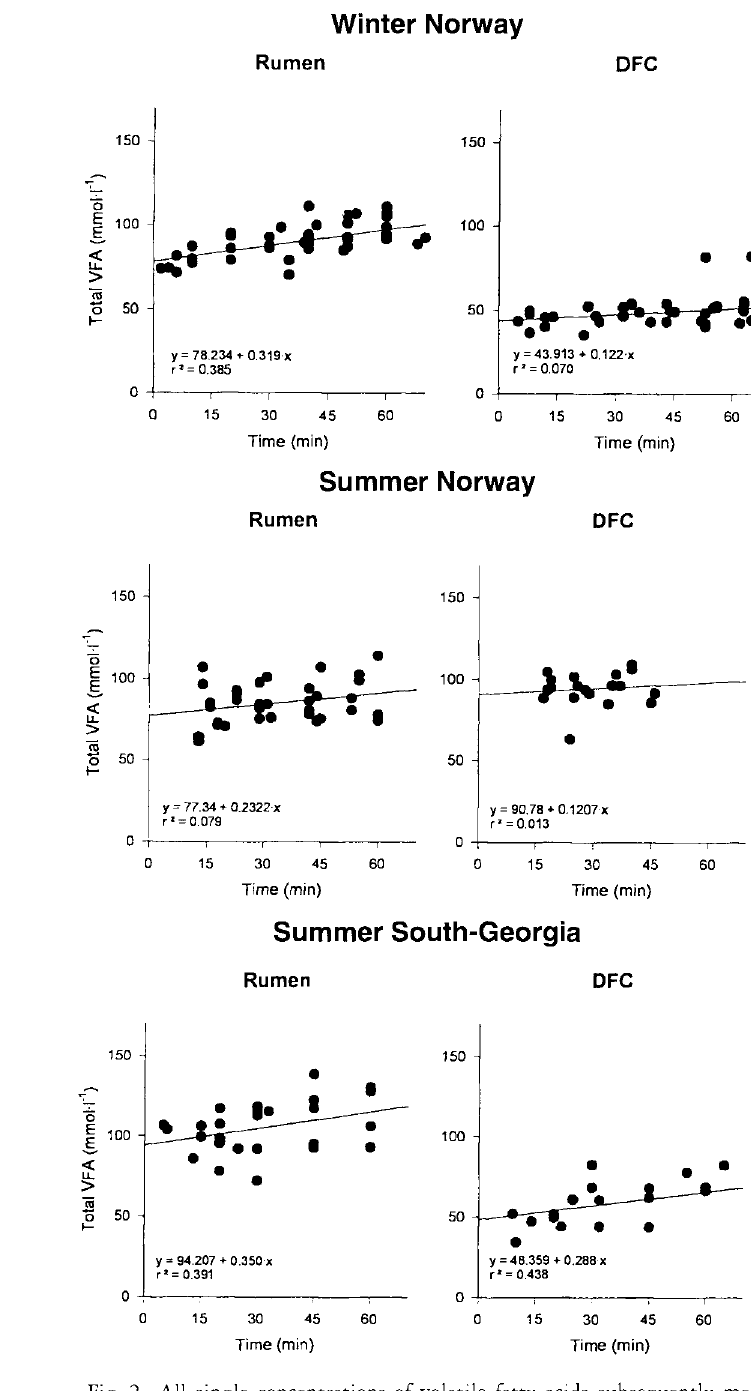
Fig. 2. All single concentrations of volatile fatty acids subsequently mea sured in each group of Norwegian reindeer (Rangifer t. tarandus) within one hour of death in the rumen and distal fermentarion cham ber (DFC) content, respectively on South Georgia (n = 6) (» = 3), in northern Norway in late summer (n = 4) (» = 3) and in northern Norway in winter (n = 9), (» =